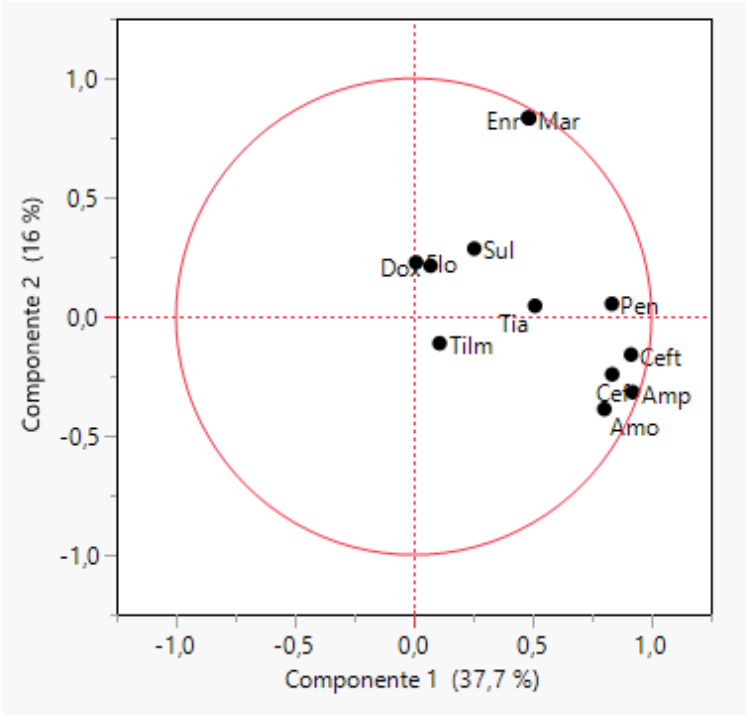
Figure 4. Biplot obtained through a principal component analysis of MIC values for twelve antimicrobials and 398 strains of Streptococcus suis . The antimicrobials tested were ampicillin (Amp), amoxicillin (Amo), cefquinome (Cef), ceftiofur (Ceft), doxycycline (Dox), enrofloxacin (Enr), florfenicol (flo), marbofloxacin (Mar), penicillin G, sulfamethoxazole/trimethoprim (Sul), tiamulin (Tia), and, tilmicosin (Tilm).